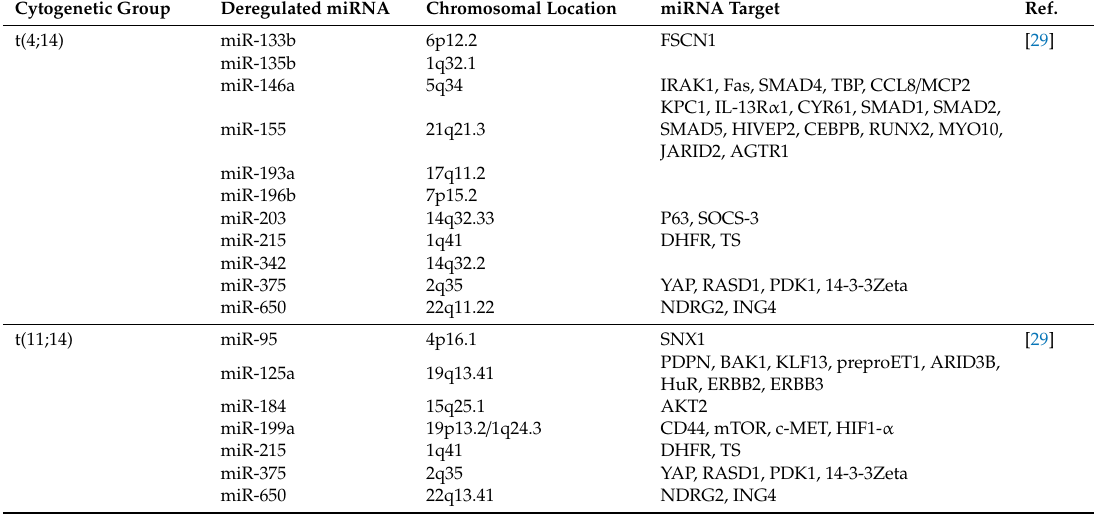
Table 1. Chromosomal abnormality and deregulated miRNA expression. Cytogenetic Group Deregulated miRNA Chromosomal Location miRNA Target